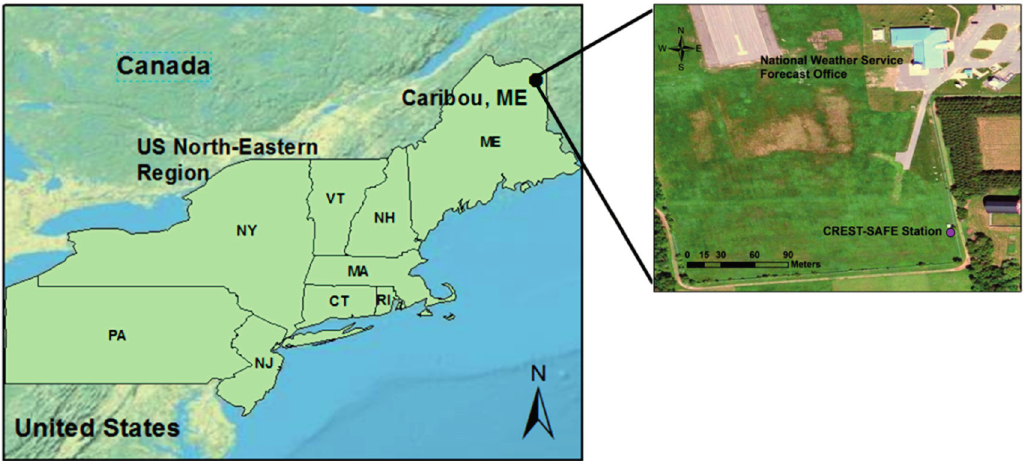
Figure 1. Cooperative Remote Sensing Science and Technology-Snow Analysis and Field Experiment (CREST-SAFE) site location. Adapted from Lakhankar 2013